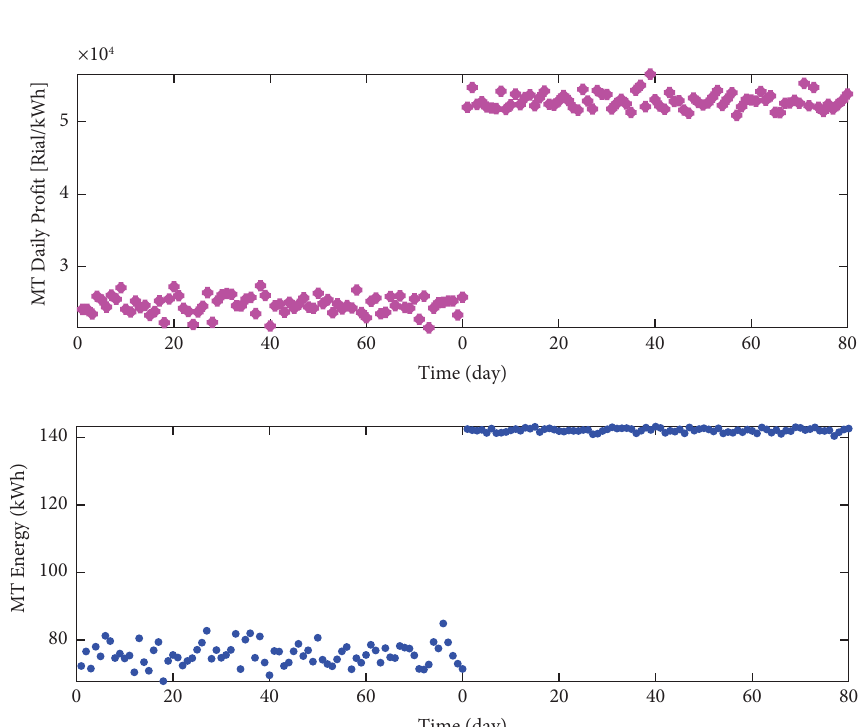
Figure 8: Average daily proft and output power of